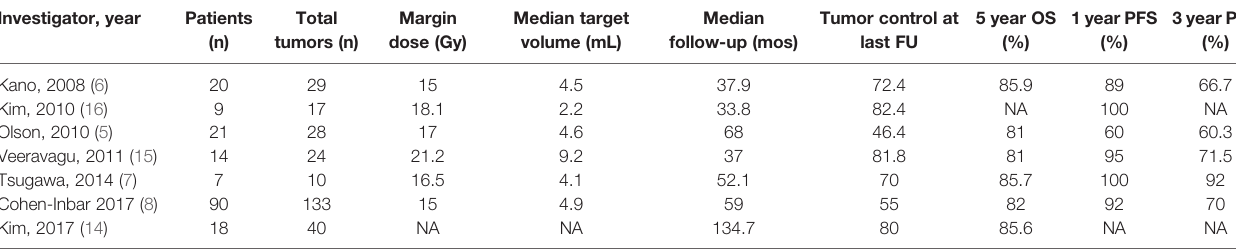
NA, Not available.